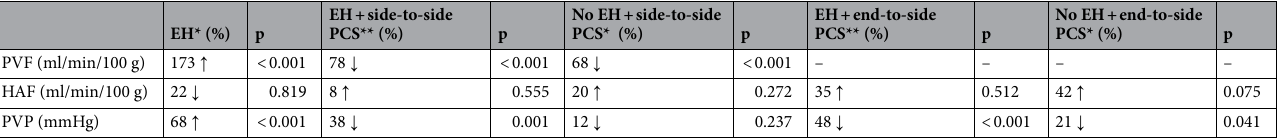
Table 1. The PVF, HAF, and PVP changes (percentage) following side-to-side and end-to-side PCS with and without EH. *Compared to the normal liver values. **Compared to the values after